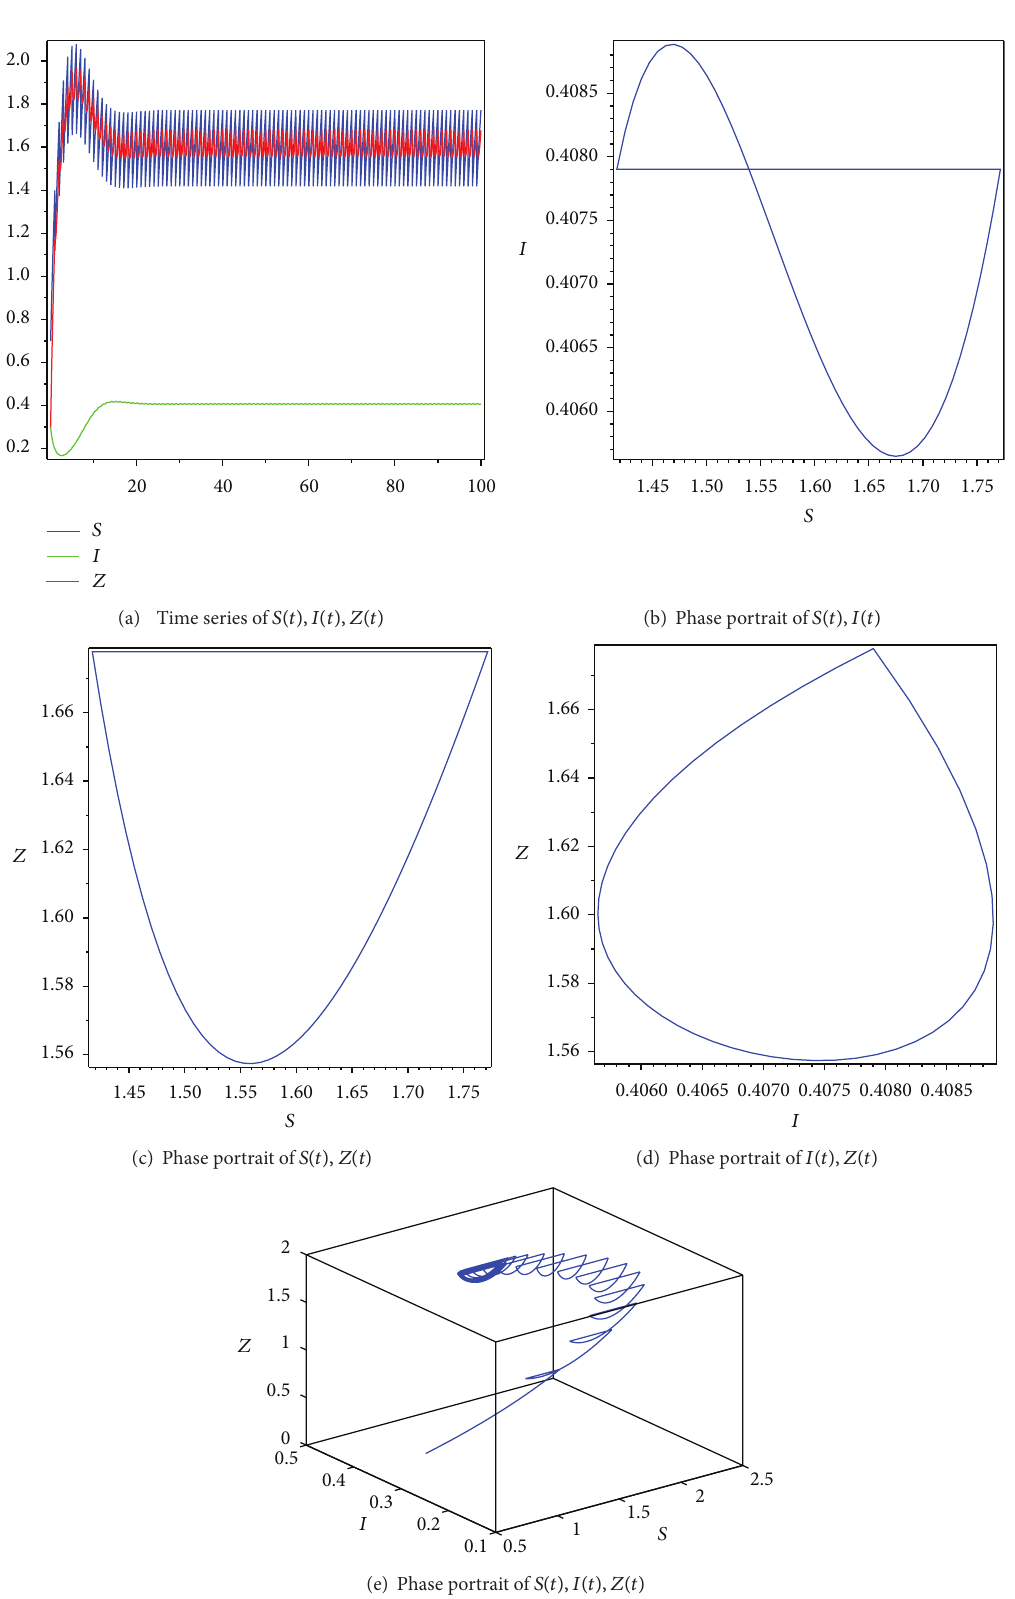
Figure 4: Illustration of basic behavior of system (9) on the threshold values R = 1.4831 > 1 , where Λ = 1, 𝜇 = 0.2, 𝛽 = 0.5, 𝑟 = 0.6, 𝑎 = 3, 𝑇 = 1 , and 𝛿 = 0.2